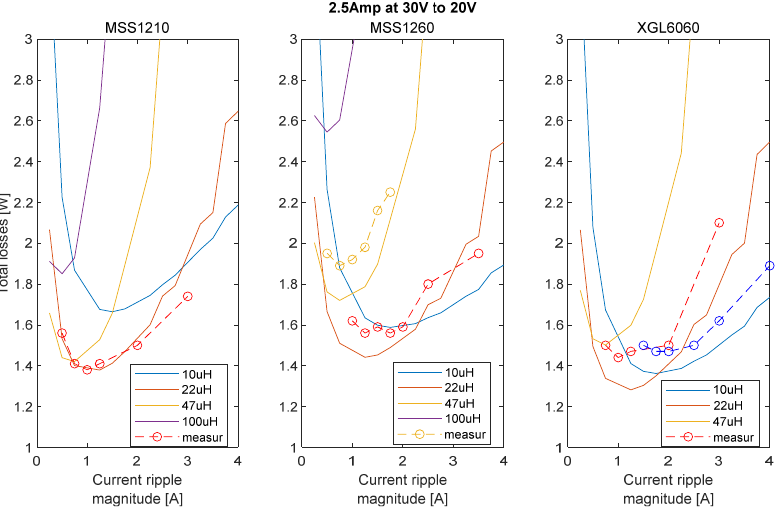
Figure 27. Optimization results compared with experimental measurements (curves with circles). For one converter processing, 50 W from 30 V to 20 V. Measure are carried out with back-to-back method. The results are plotted with respect to current ripples into the main inductors.